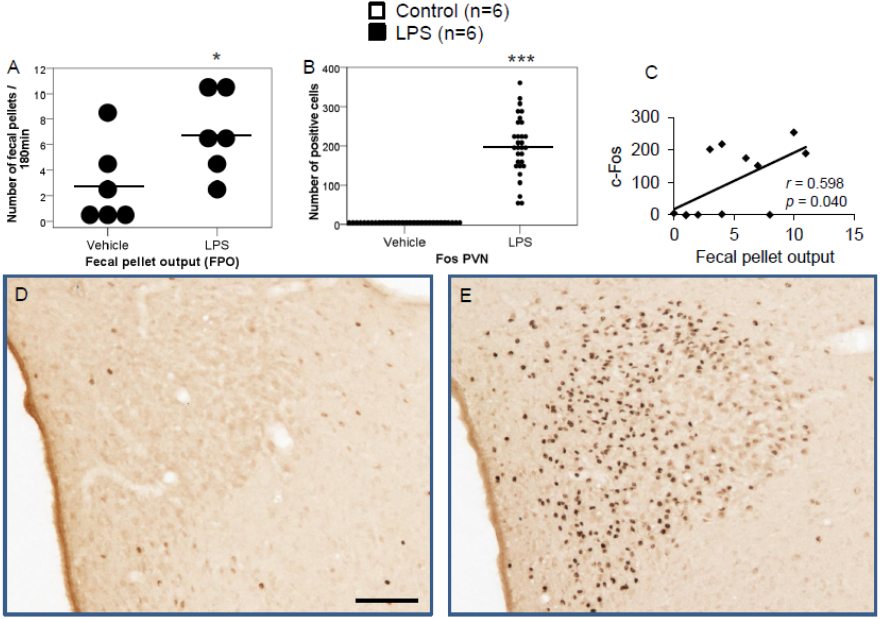
Figure 1. LPS significantly increases fecal pellet output (FPO) compared to control ( A ). LPS stimulates c-Fos expression in the paraventricular nucleus. Ad libitum-fed rats were subjected to IP injection of LPS or control, and 180 min after the injection, brains were processed for c-Fos and phoenixin double-immunohistochemistry. LPS stress significantly increased the number of c-Fos-positive cells compared to controls ( B ) and the number of c-Fos positively correlated with fecal pellet output ( C ). Representative pictures of the evaluated slides are shown in ( D ) (control) and ( E ) (LPS). The scale bar represents 100 µ m in the overview. Data are expressed as individual data points (5/animal) and mean in ( A , B ). Mean values per animal are plotted in ( C ). * p < 0.05, *** p <